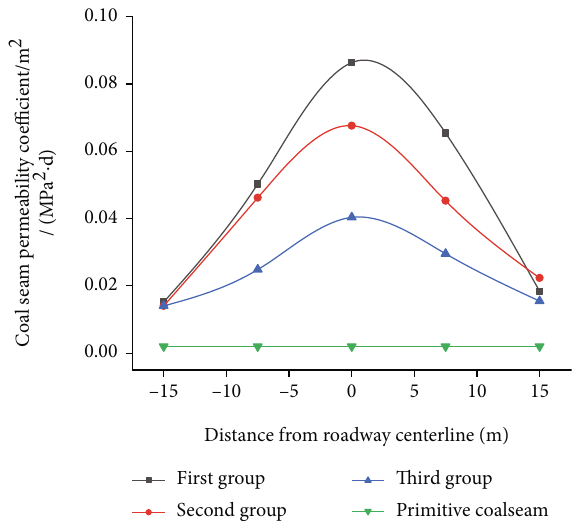
Figure 12: Gas permeability coe ffi cient of overlying coal seam in 213 fl oor